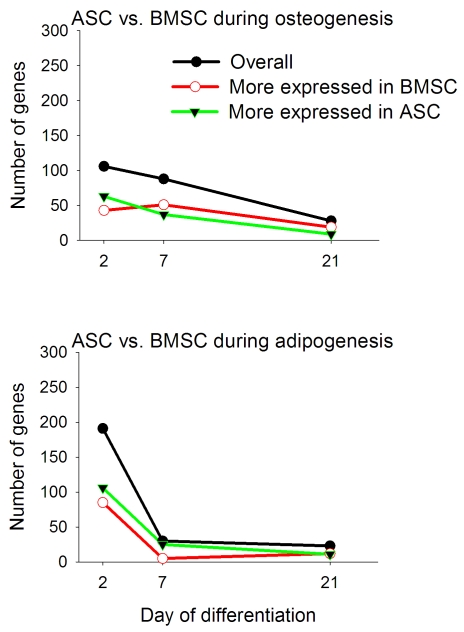
Number of transcripts differentially expressed in BMSC vs. ASC during adipogenic and osteogenic differentiation.Number of transcripts differentially expressed in BMSC vs. ASC in adipogenic and osteogenic differentiation at each time point. The image reports also the number of genes more expressed in BMSC vs. ASC (red line) or more expressed in ASC vs. BMSC (green line).